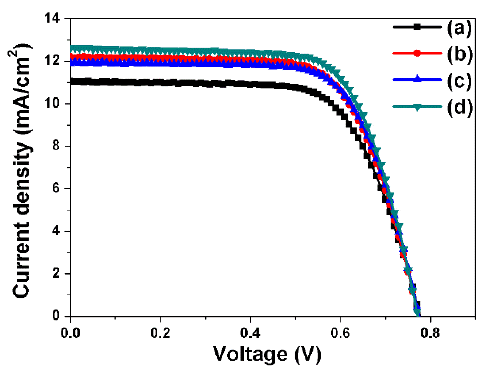
Figure 4. I–V curves of DSSC-based closed-ended freestanding TiO 2 nanotube arrays fabricated without NPs ( a ), with Ag NPs ( b ), with large TiO 2 NPs ( c ), and with Ag NPs and large TiO 2 NPs ( d ).